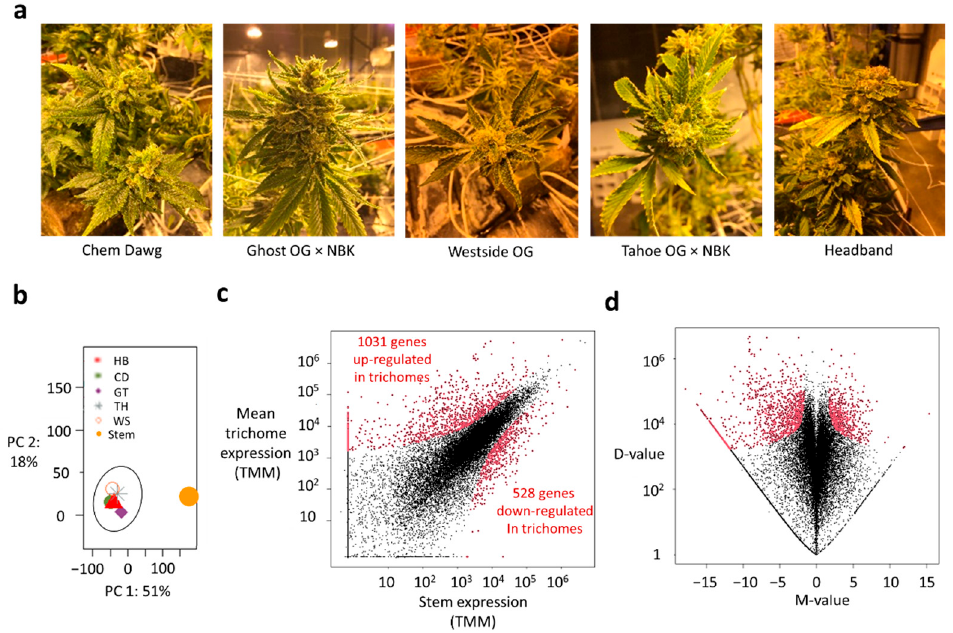
Figure 1. Quality assessment and differential analysis of gene expression data. ( a ) Picture of Cannabis cultivars selected for investigation. ( b ) Score plot of trichome and stem samples according to the first and second components (PC 1 and PC 2) obtained from a principal component analysis. ( c ) Plot of average gene expression values for the trichomes of five cultivars versus the corresponding expression in the stem tissue of HB. ( d ) M-D plot of global gene expression data. (M-value: log 2 FC value; D-value: absolute-difference-in-expression value). Red dots in ( c , d ) denote genes that are differentially expressed. HB: Headband; CD: Chem Dawg; GT: Ghost OG × NBK; TH: Tahoe OG × NBK; WS: Westside